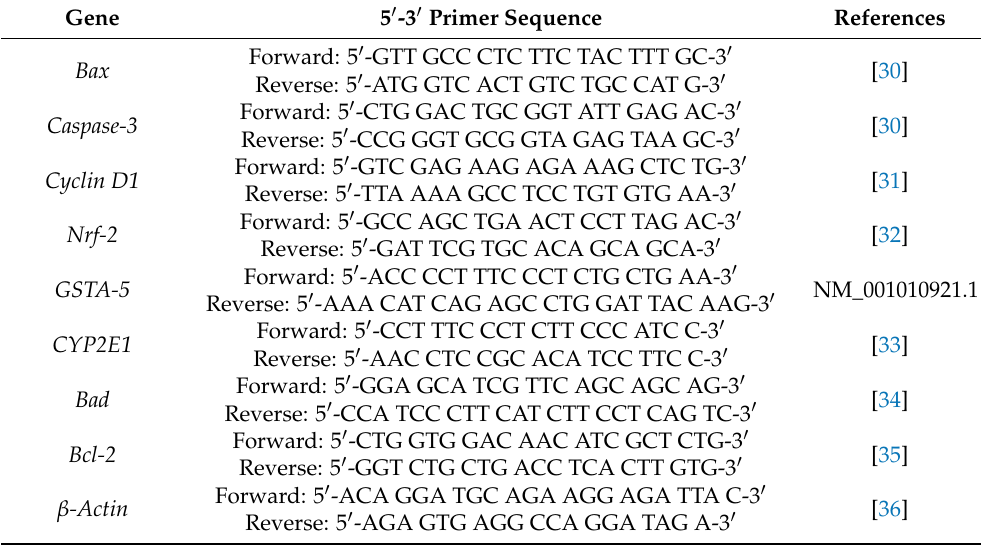
Table 3. Primer sequences for real-time polymerase chain